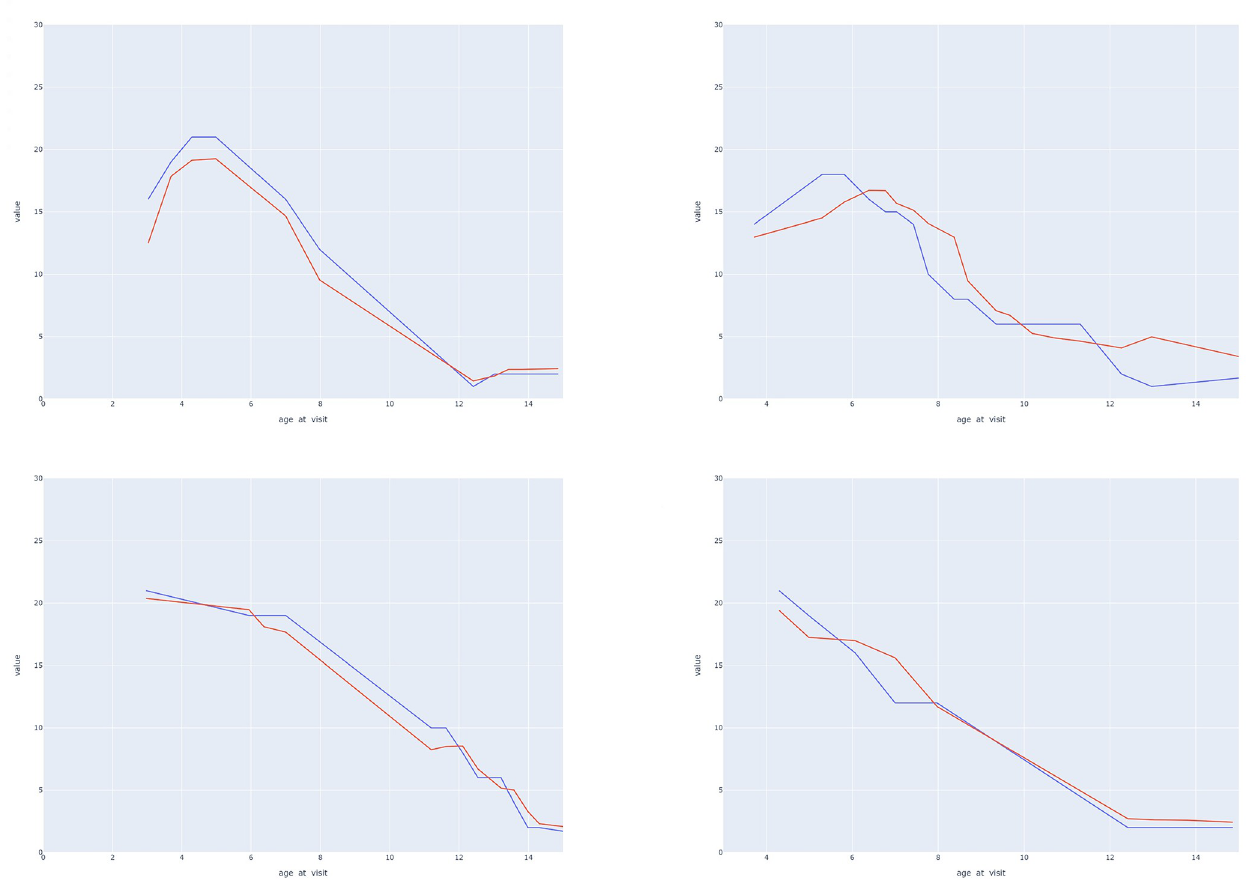
Fig 3. Trajectory predictions on the testing set for 4 patients. Key to figure: Blu line = actual HFMSE progression, Red line = model-predicted HFMSE progression.